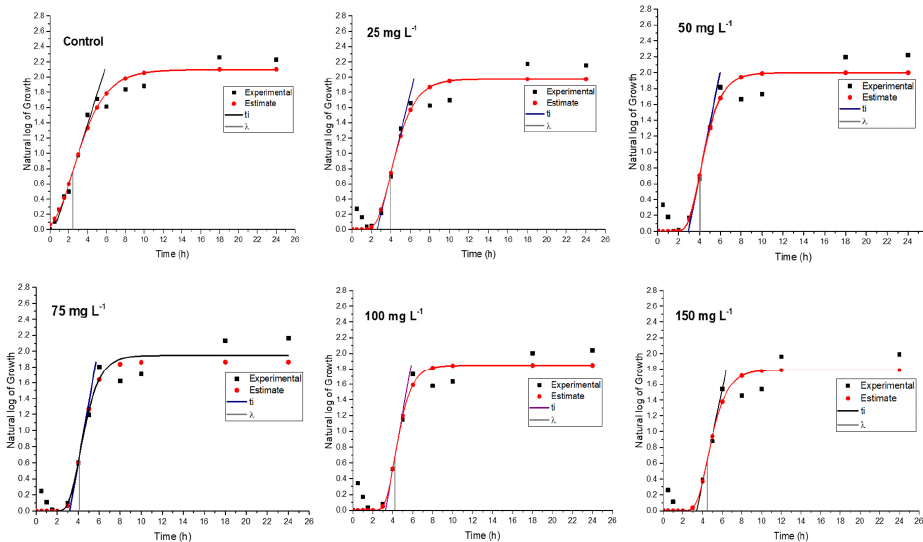
Figure 6. Experimental and predicted MRSE growth curve in response to rosin treatment.